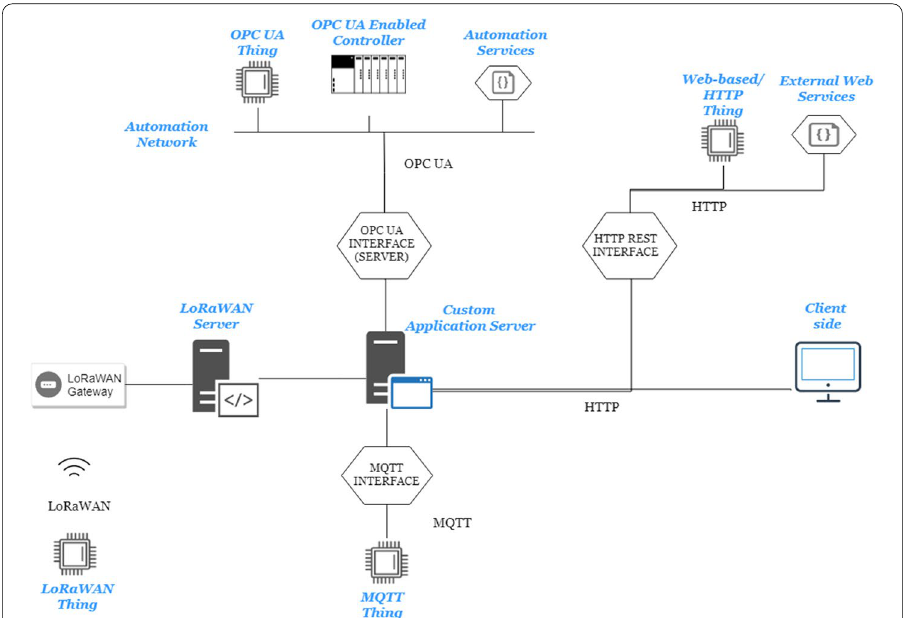
Fig. 1 The communication architecture to integrate IoT